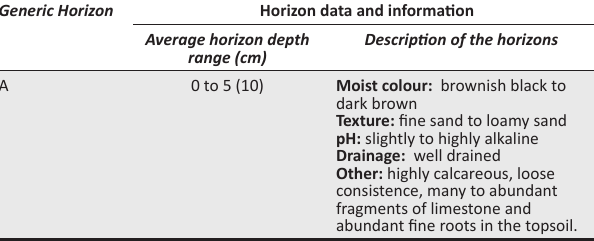
TABLE A1.5b: Differentiating characteristics of the molic